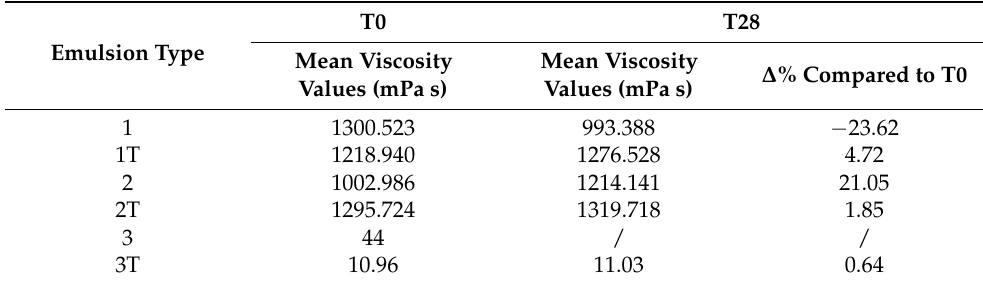
Table 3. viscosity values. Table 3. Viscosity values.